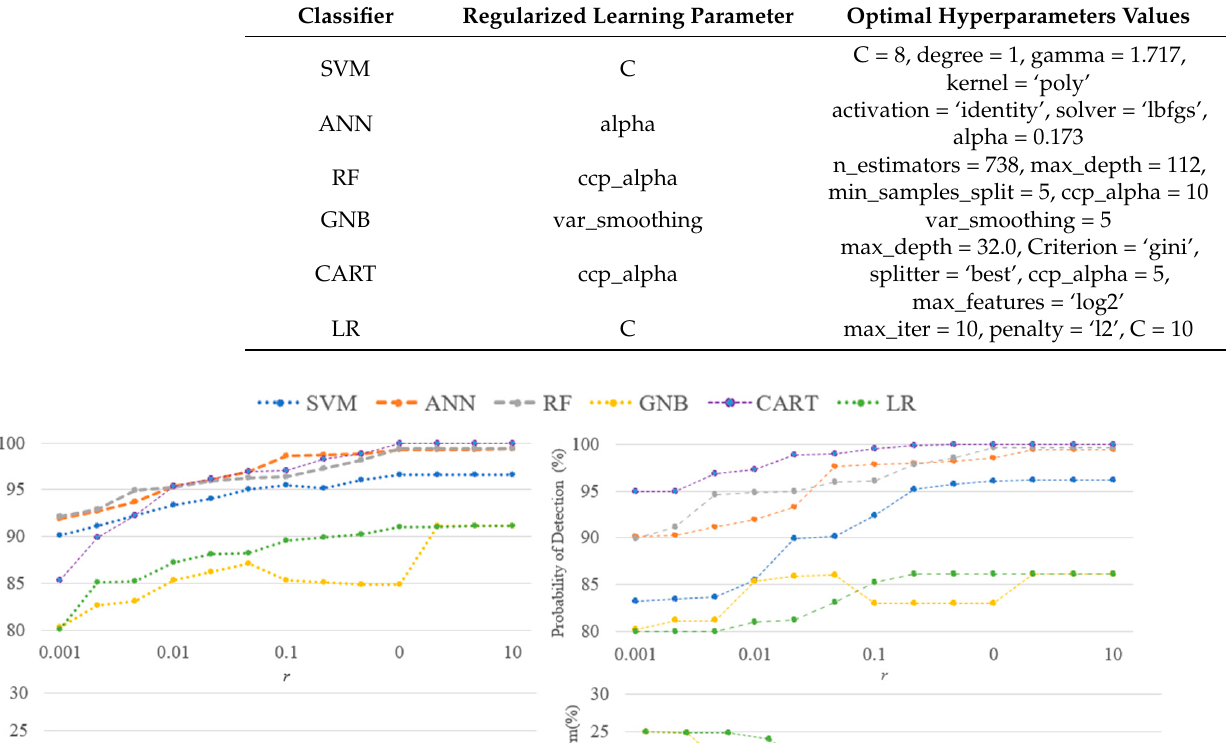
Table 3. Hyperparameter settings.